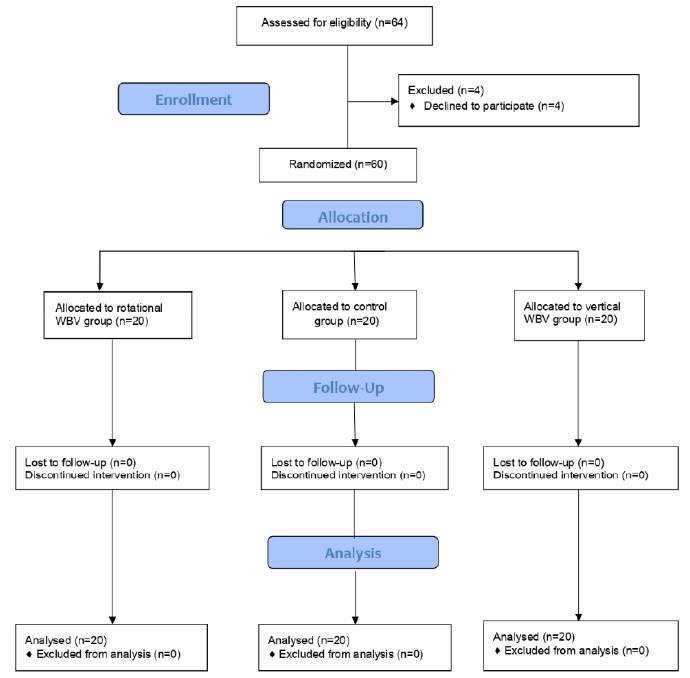
Figure 1. CONSORT flow diagram.